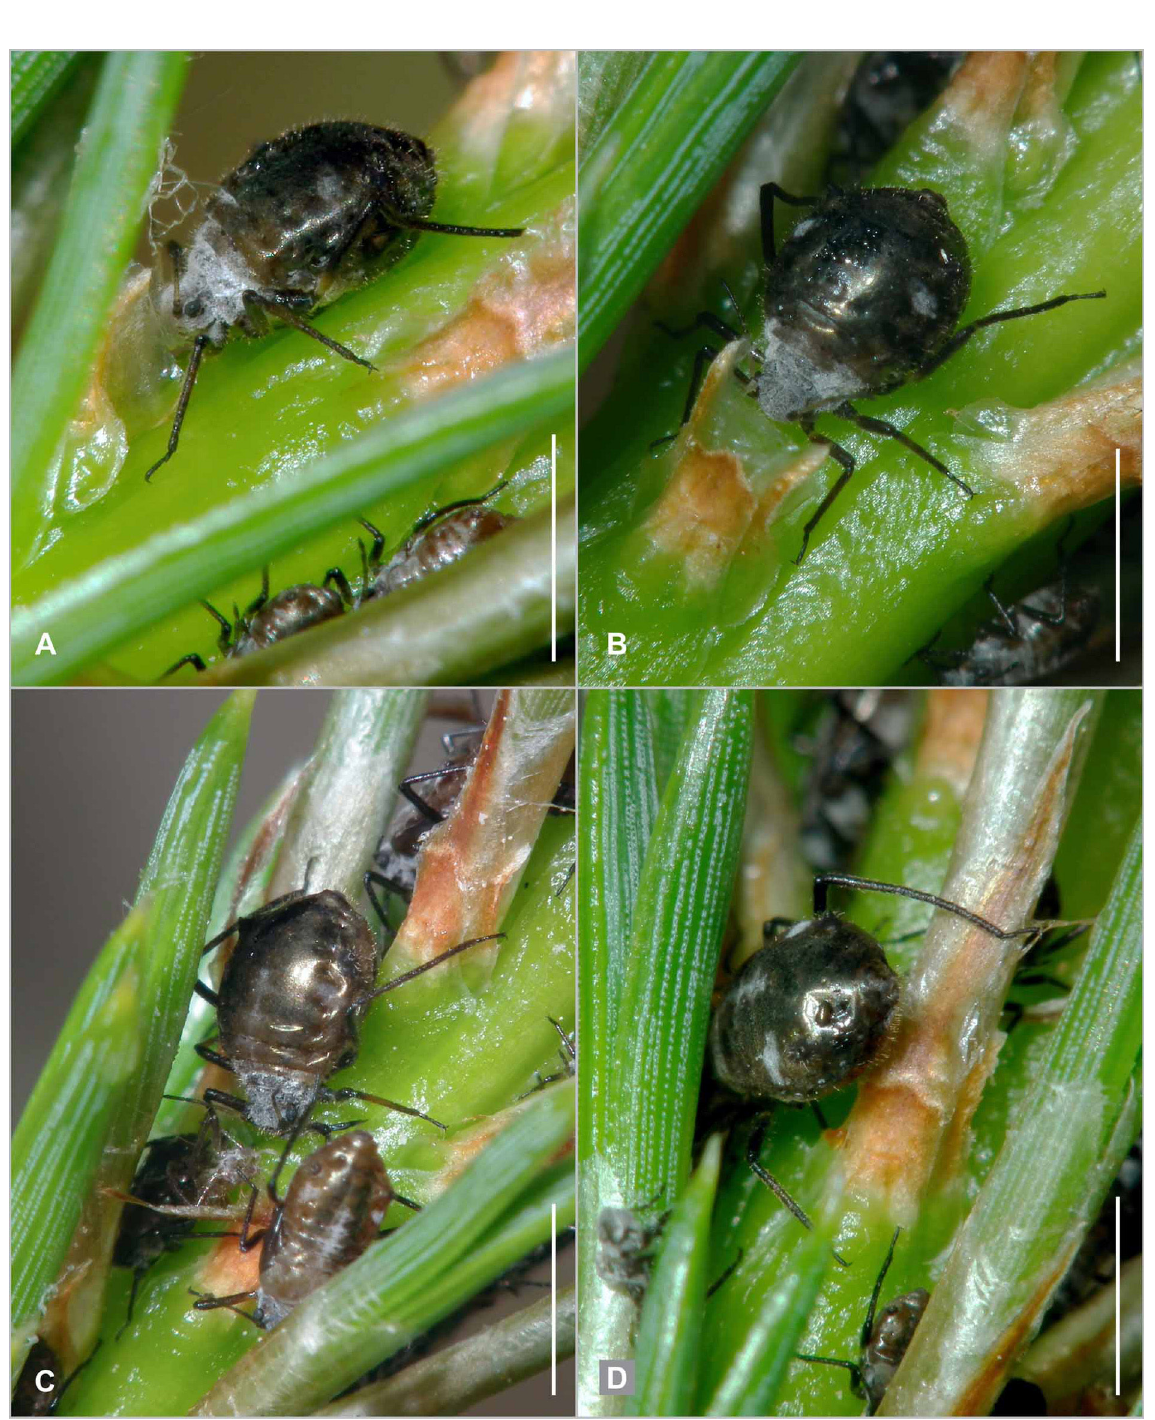
Fig. 108. Cinara (Cinara) hyperophila (Koch, 1855). Apterae and juvenile alatae on young shoot of Pinus sylvestris . Scale bars: 2